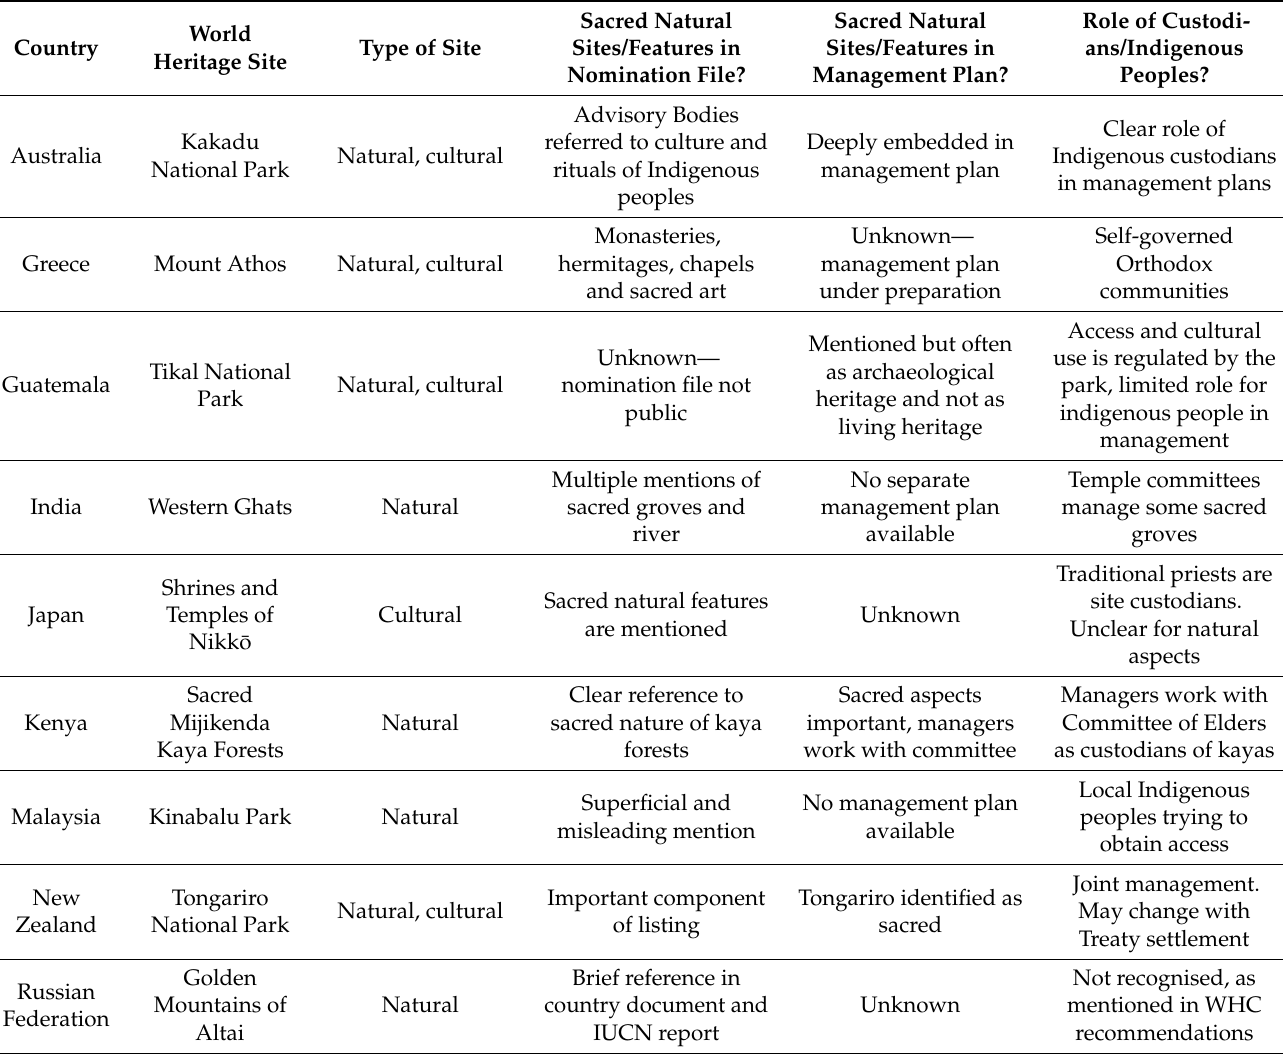
Table 3. Analysis of